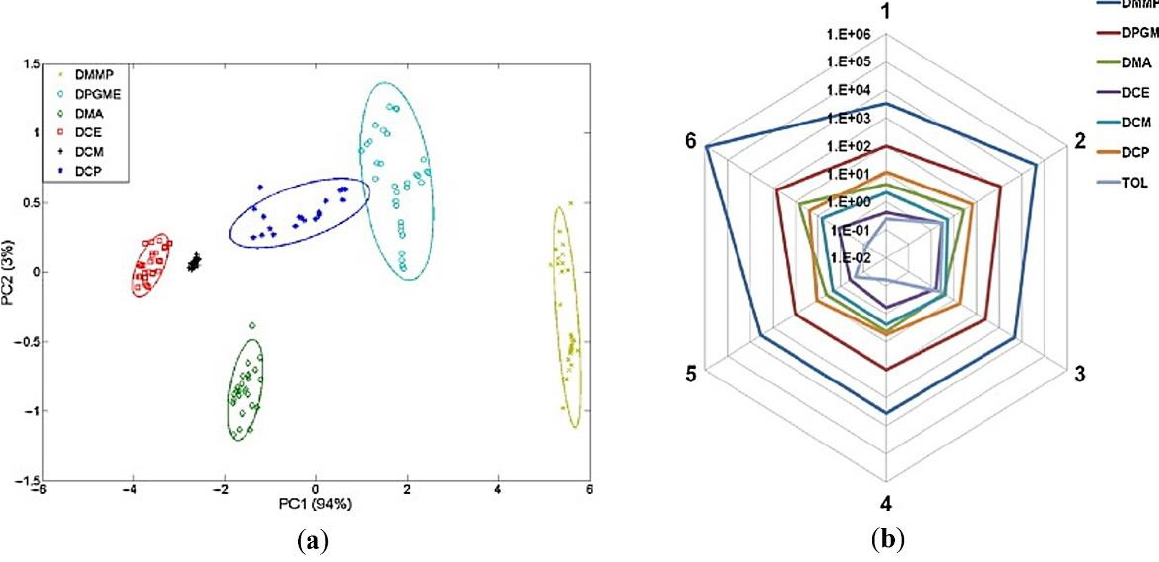
Figure 4. Some methods of interpreting the response of sensor array: ( a ) Principal Component Anal- ysis (PCA) obtained for the matrix of six Love wave sensors. In this case, the PCA made it possible to clearly distinguish six compounds that are simulants of sulfur mustard, nitrogen mustard, and sarin. ( b ) The radial plot of array response. Each axis represents an individual sensor and the